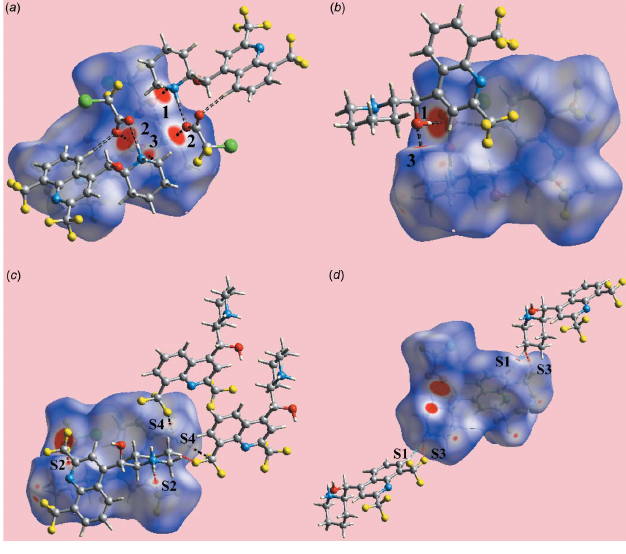
Figure 3 Views of the Hirshfeld surface of (I) mapped over d norm in the range (cid:3) 0.077 to +1.575 au, highlighting: ( a ) and ( b ) intermolecular hydrogen bonds (with labels 1–3) by black-dashed lines, and ( c ) and ( d ) short interatomic H (cid:2)(cid:2)(cid:2) H, F (cid:2)(cid:2)(cid:2) H and F (cid:2)(cid:2)(cid:2) F contacts (with labels S1–S4) by sky- blue, red and black dashed lines, respectively.